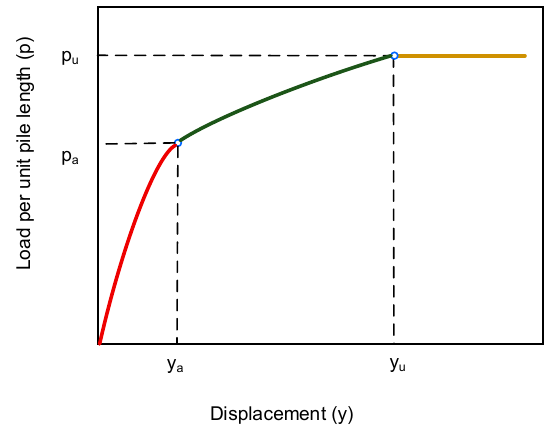
Figure A1. P–Y curve for weak rock, after [65].